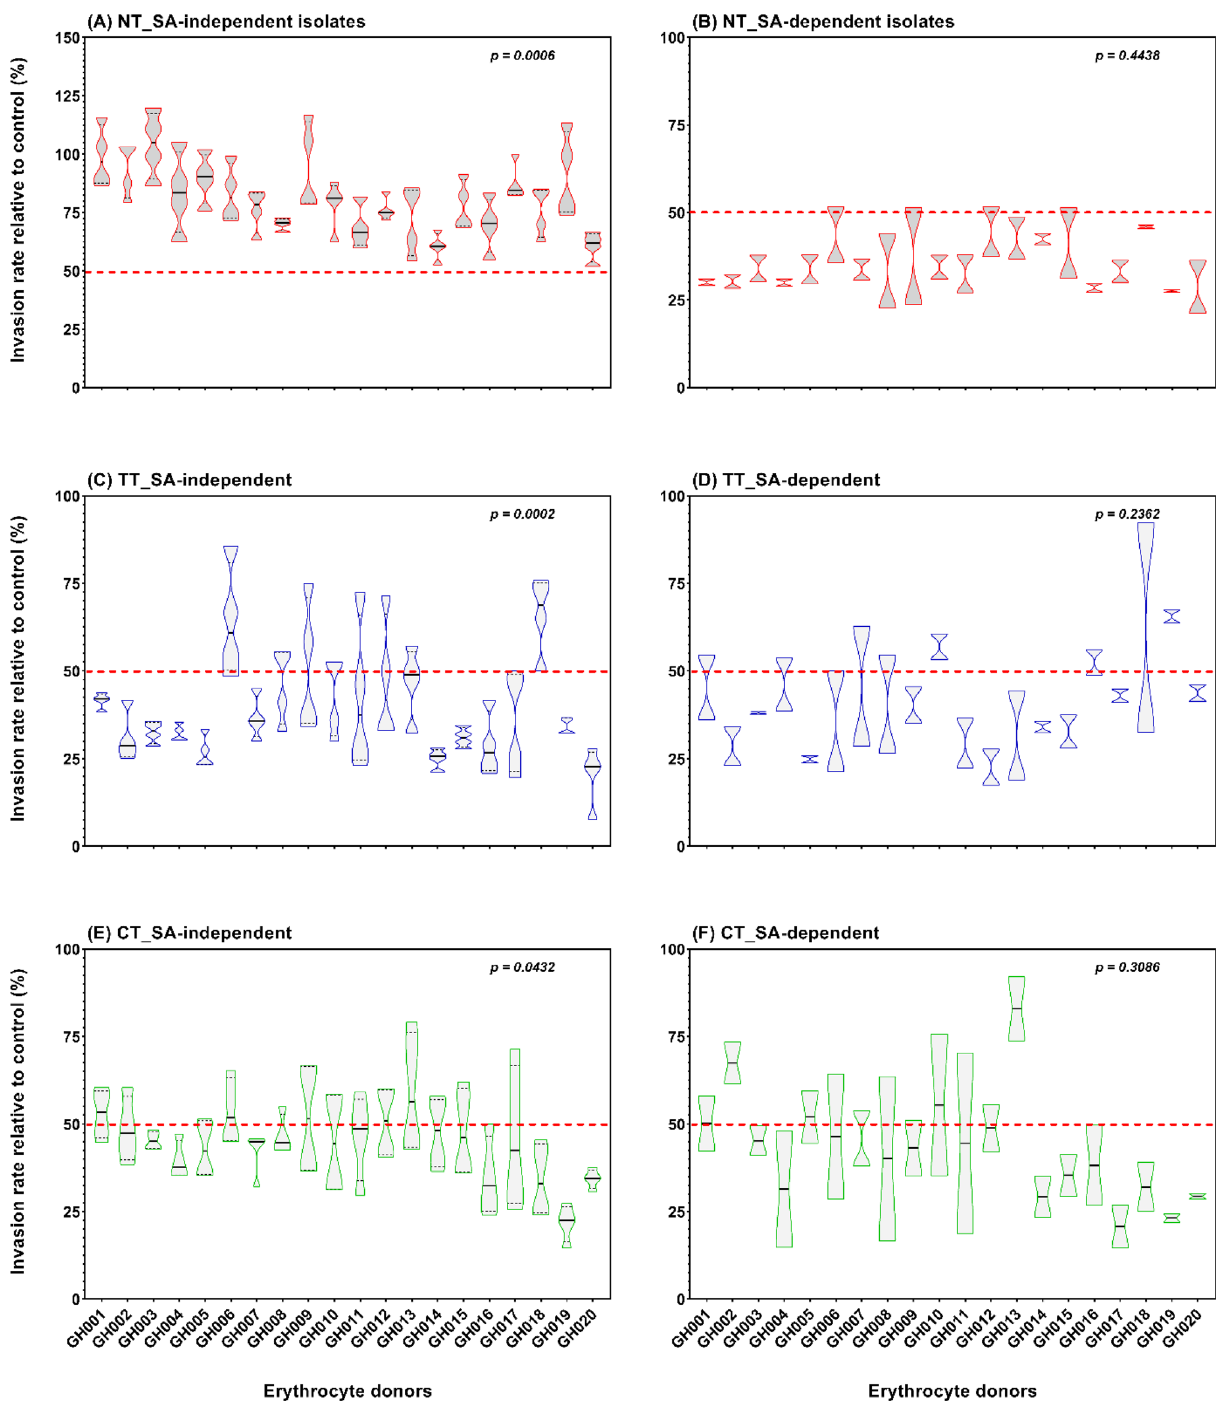
Figure 3. P. falciparum invasion phenotypes into erythrocytes from twenty different donors. The assay was set up along with a single donor erythrocyte used as a control for normalizing the resulting parasitemia. Presented are the violin plots showing the invasion efficiencies from six different P. falciparum strains assayed in triplicates in two independent experiments. The right panel graphs ( A , C , E ) represent the invasion phenotype of SA-independent isolates (3D7, MISA010, MISA011 and MISA018) while that of the SA-dependent isolates (Dd2 and W2mef) is represented on the left panel graphs ( B , D , F ). The red-dotted line indicates the sensitivity cut off for each given treatment. Statistical analyses were performed using One-way ANOVA. Key: SA sialic acid, NT neuraminidase treatment, TT trypsin treatment and CT chymotrypsin